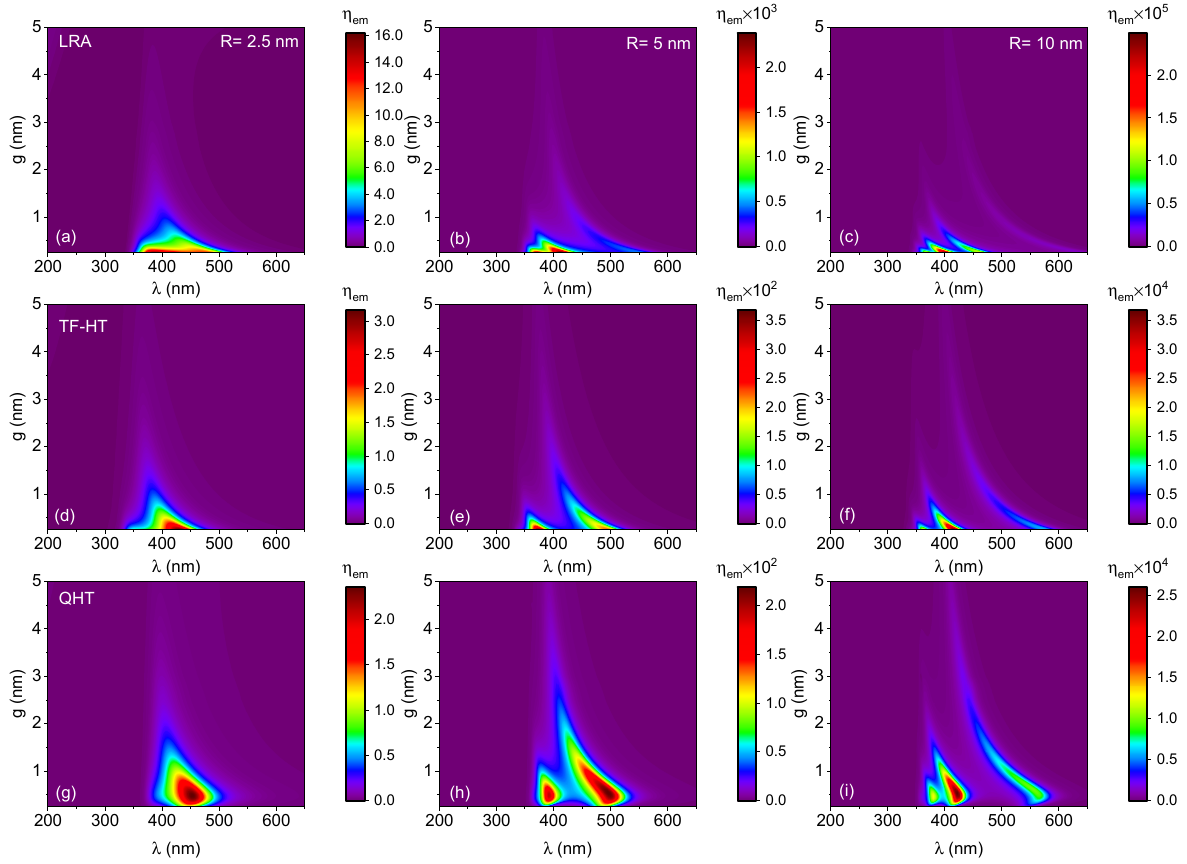
Figure 4: The fluorescence enhancement for different radii, g and 𝜆 evaluated for the LRA, TF-HT and QHT.